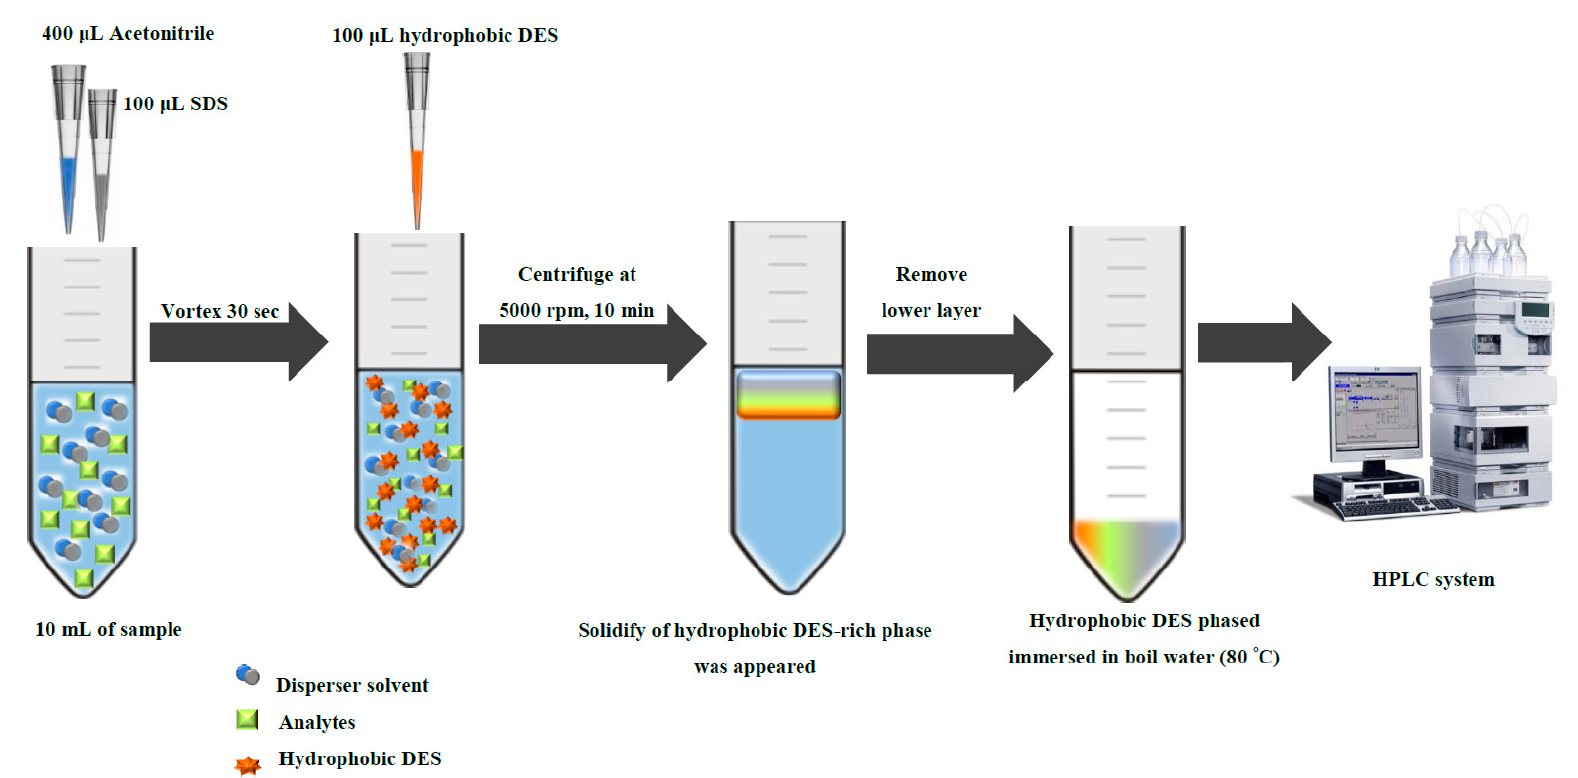
Figure 7. Schematic for a hydrophobic deep eutectic solvent-based dispersive liquid–liquid microextraction.